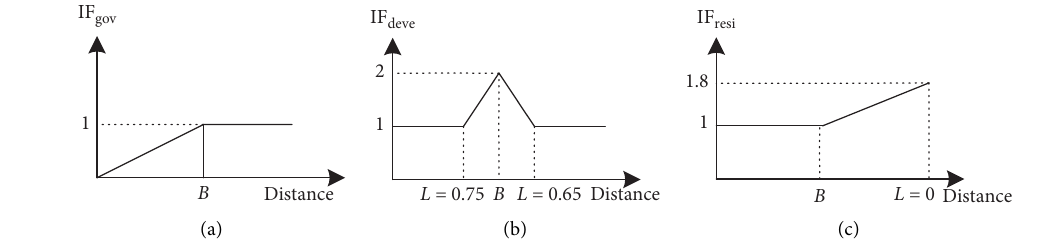
Figure 13: The impact factors of three